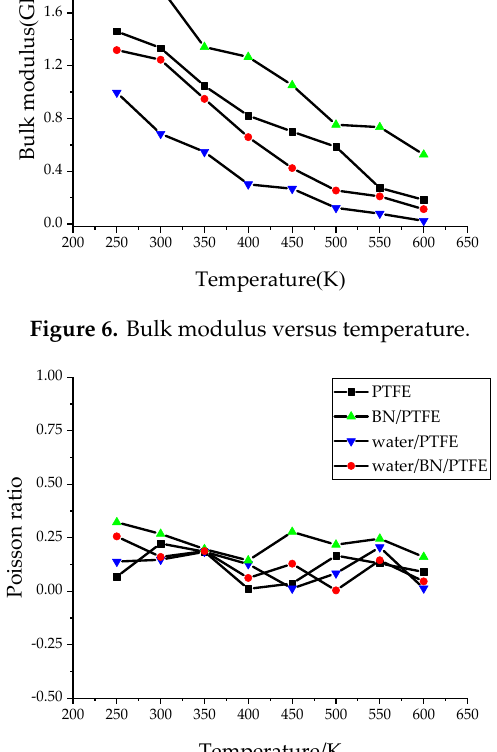
Figure 7. Poisson’s ratio versus temperature.